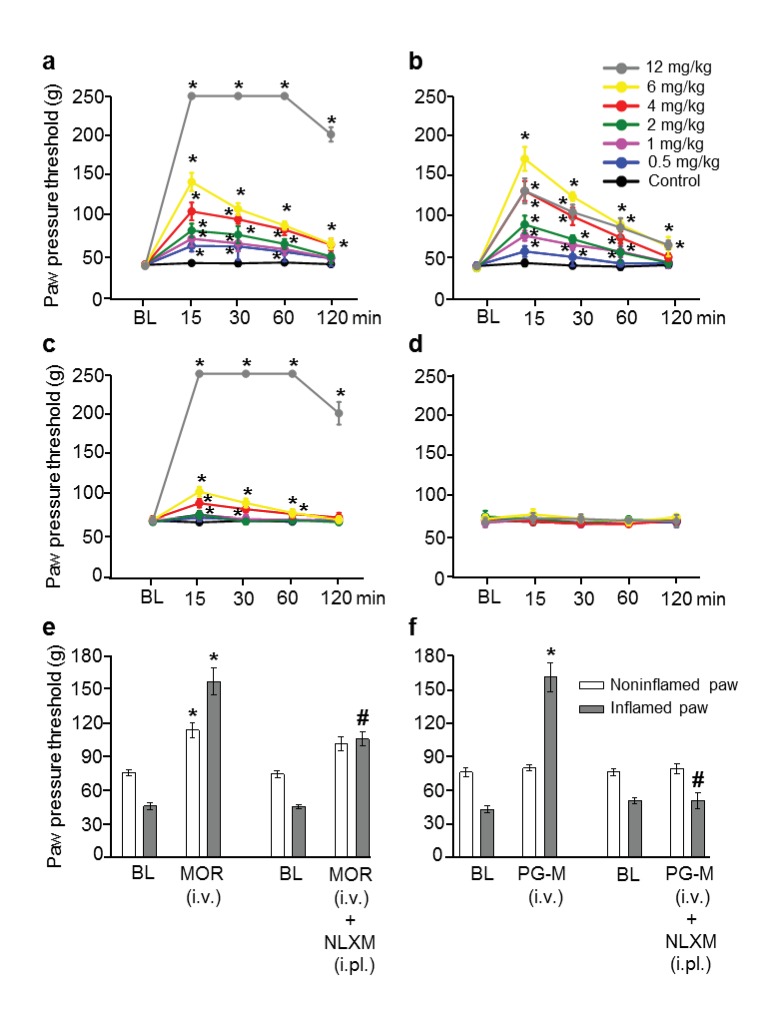
Analgesic effects after intravenous (i.v.) morphine or PG-M in rats with unilateral hindpaw inflammation.Effects on mechanical pain thresholds (PPT) in inflamed (a, b) and noninflamed (c, d) hindpaws following i.v. injections of morphine (MOR; a, c, e) or PG-M (b, d, f). Dosages of MOR and PG-M represent the absolute amounts of morphine free base (see Table 1). Bilateral intraplantar (i.pl.) injection of NLXM (50 μg/paw) partially reduced peak PPT elevations occurring at 15 min after MOR (6 mg/kg; e) and completely abolished effects after PG-M (equivalent to 6 mg/kg morphine; f). (a, b, c) *p<0.05, two-way RM-ANOVA and Bonferroni test (compared to controls). (e, f) *p<0.05, paired t-test (BL vs. agonist without/with NLXM); #p<0.05, unpaired t-test (agonist vs. agonist with NLXM). N = 8 rats per group; means ± SEM. PPT increases in a, c (0–12 mg/kg) and b (0–6 mg/kg) were dose-dependent (p<0.05, linear regression ANOVA).DOI:
http://dx.doi.org/10.7554/eLife.27081.01010.7554/eLife.27081.011Figure 7—source data 1.Raw data for Figure 7.